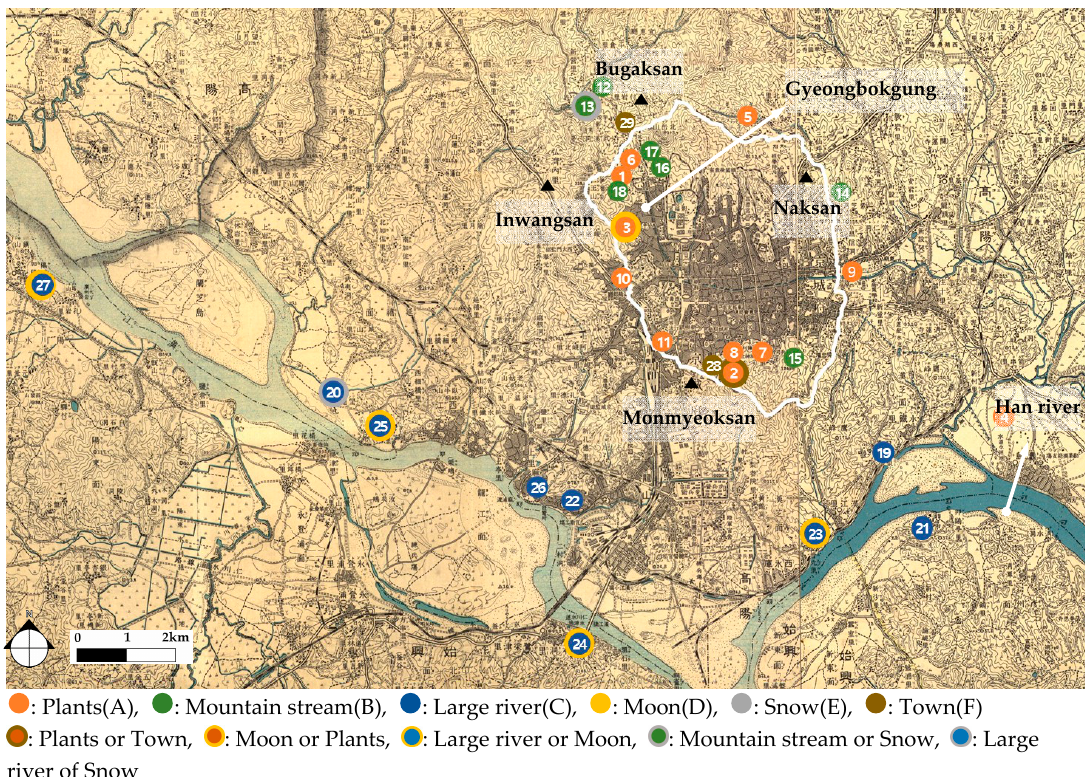
Figure 1. Distribution of noted natural places.